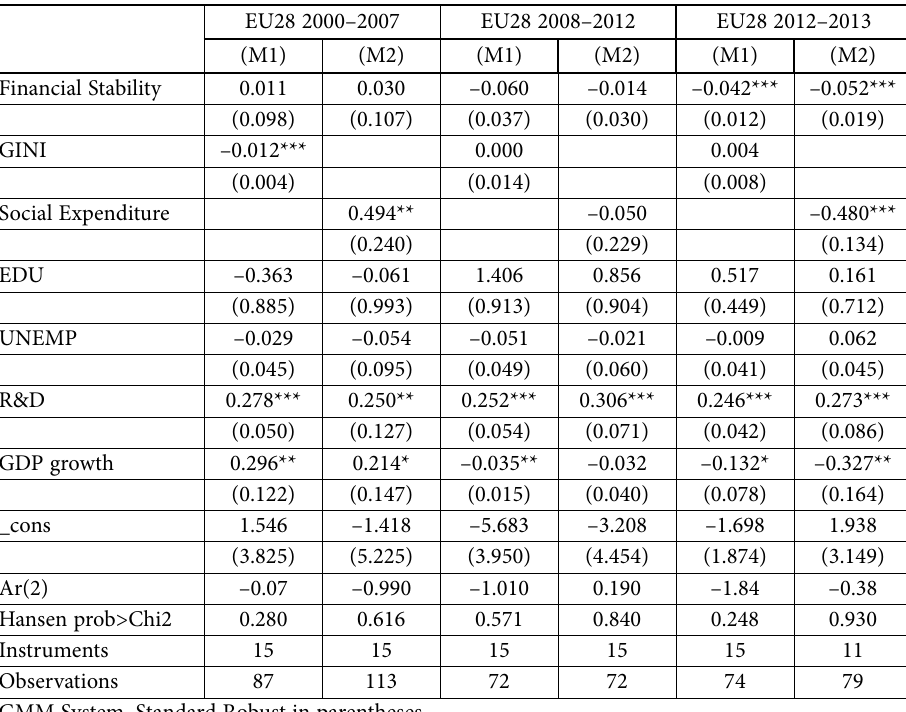
Table 5. Results relative to the economic crisis period Table 5.1. European Union